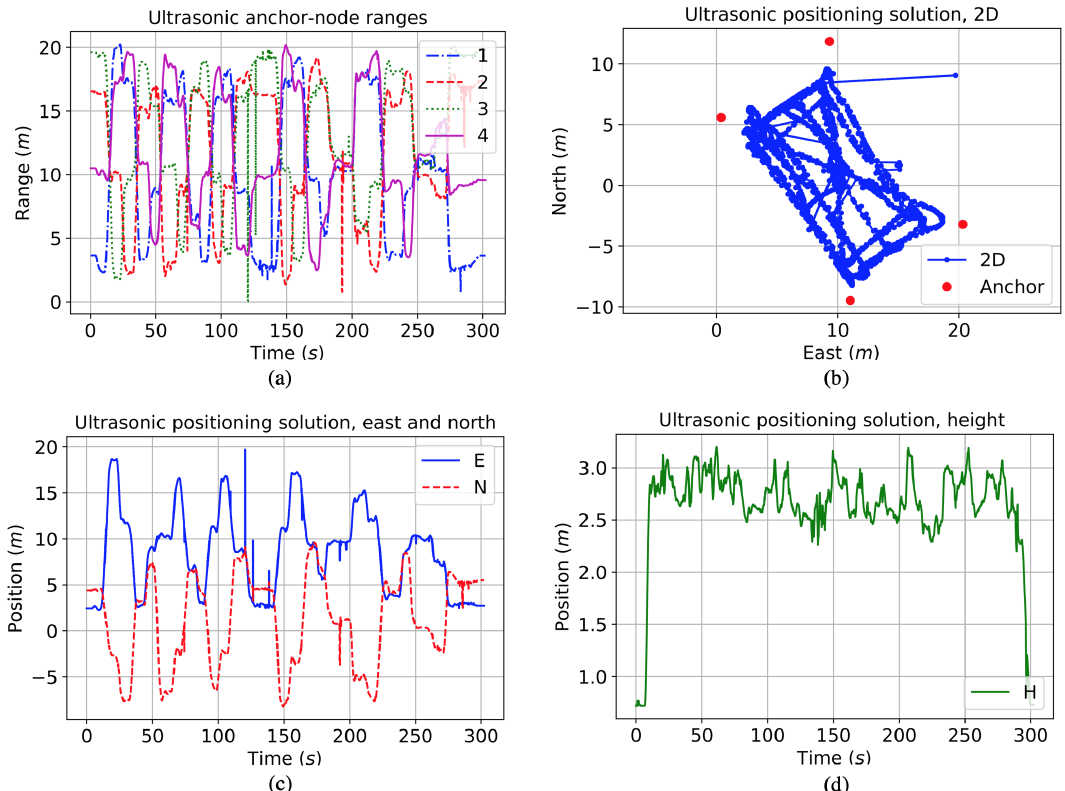
Figure 9. ( a ) Raw ultrasonic measurements and ( b ) position, ( c ) velocity, and ( d ) height